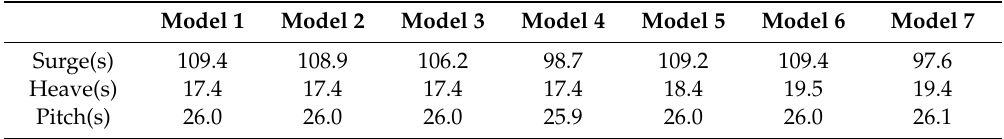
Table 7. Natural period of each model.